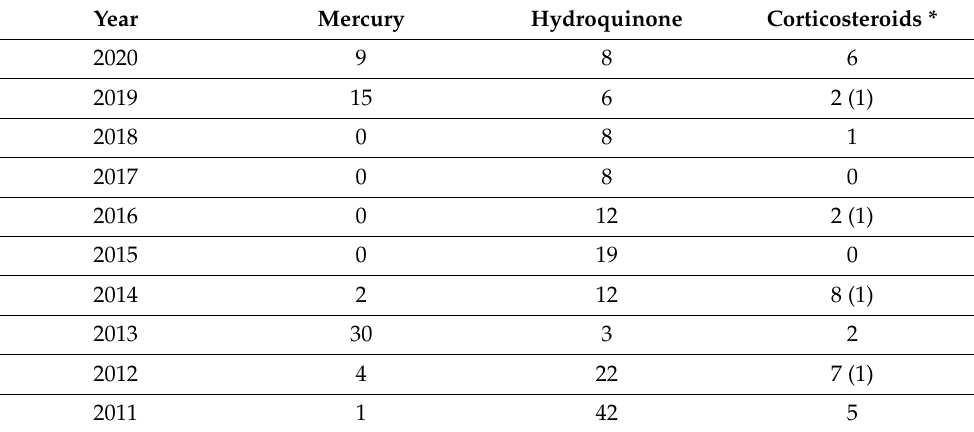
Table 3. Skin-lighteners not complying with Regulation 1223/2009 notified in the period 2011–2020 on the Safety Gate website (* Numbers in brackets refer to betamethasone